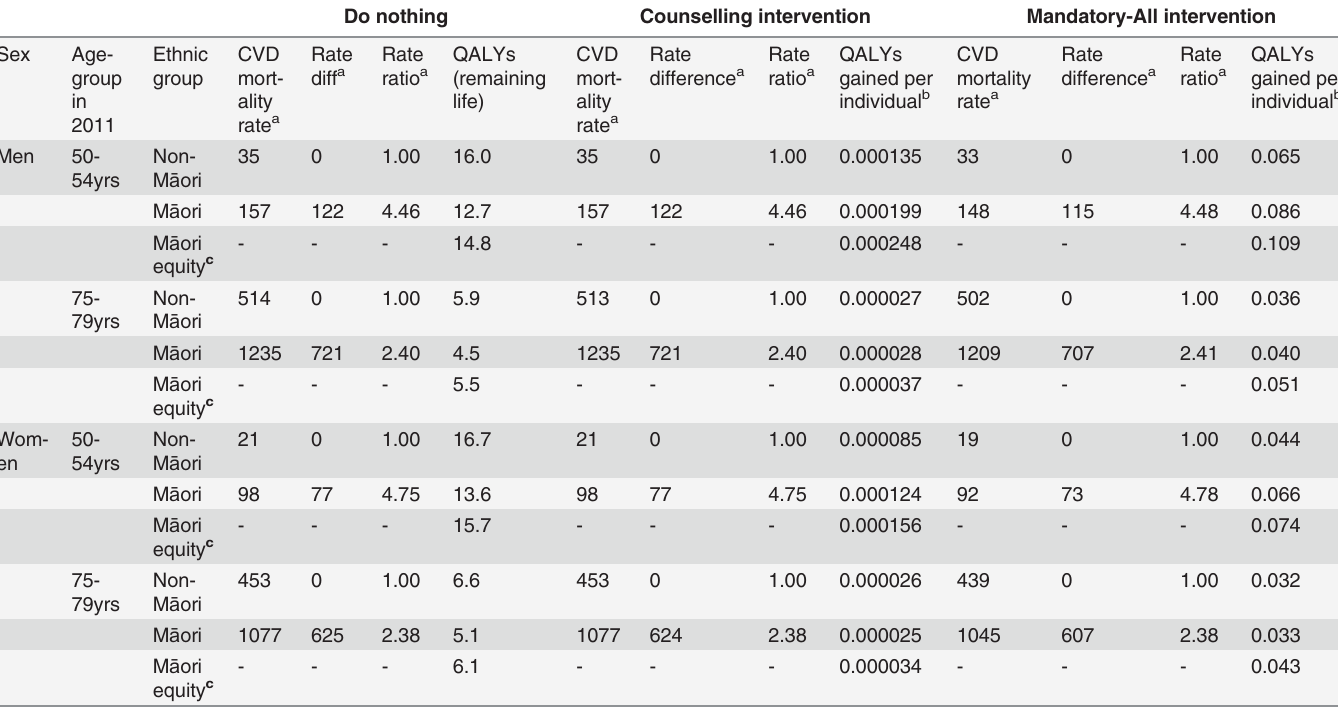
Table 6. Ethnic inequality impacts after 10 years from two sodium reduction interventions (CVD mortality rates, rate ratios and rate differences, and QALYs gained for individuals given model structure assumptions and parameter inputs for selected age-groups). Do